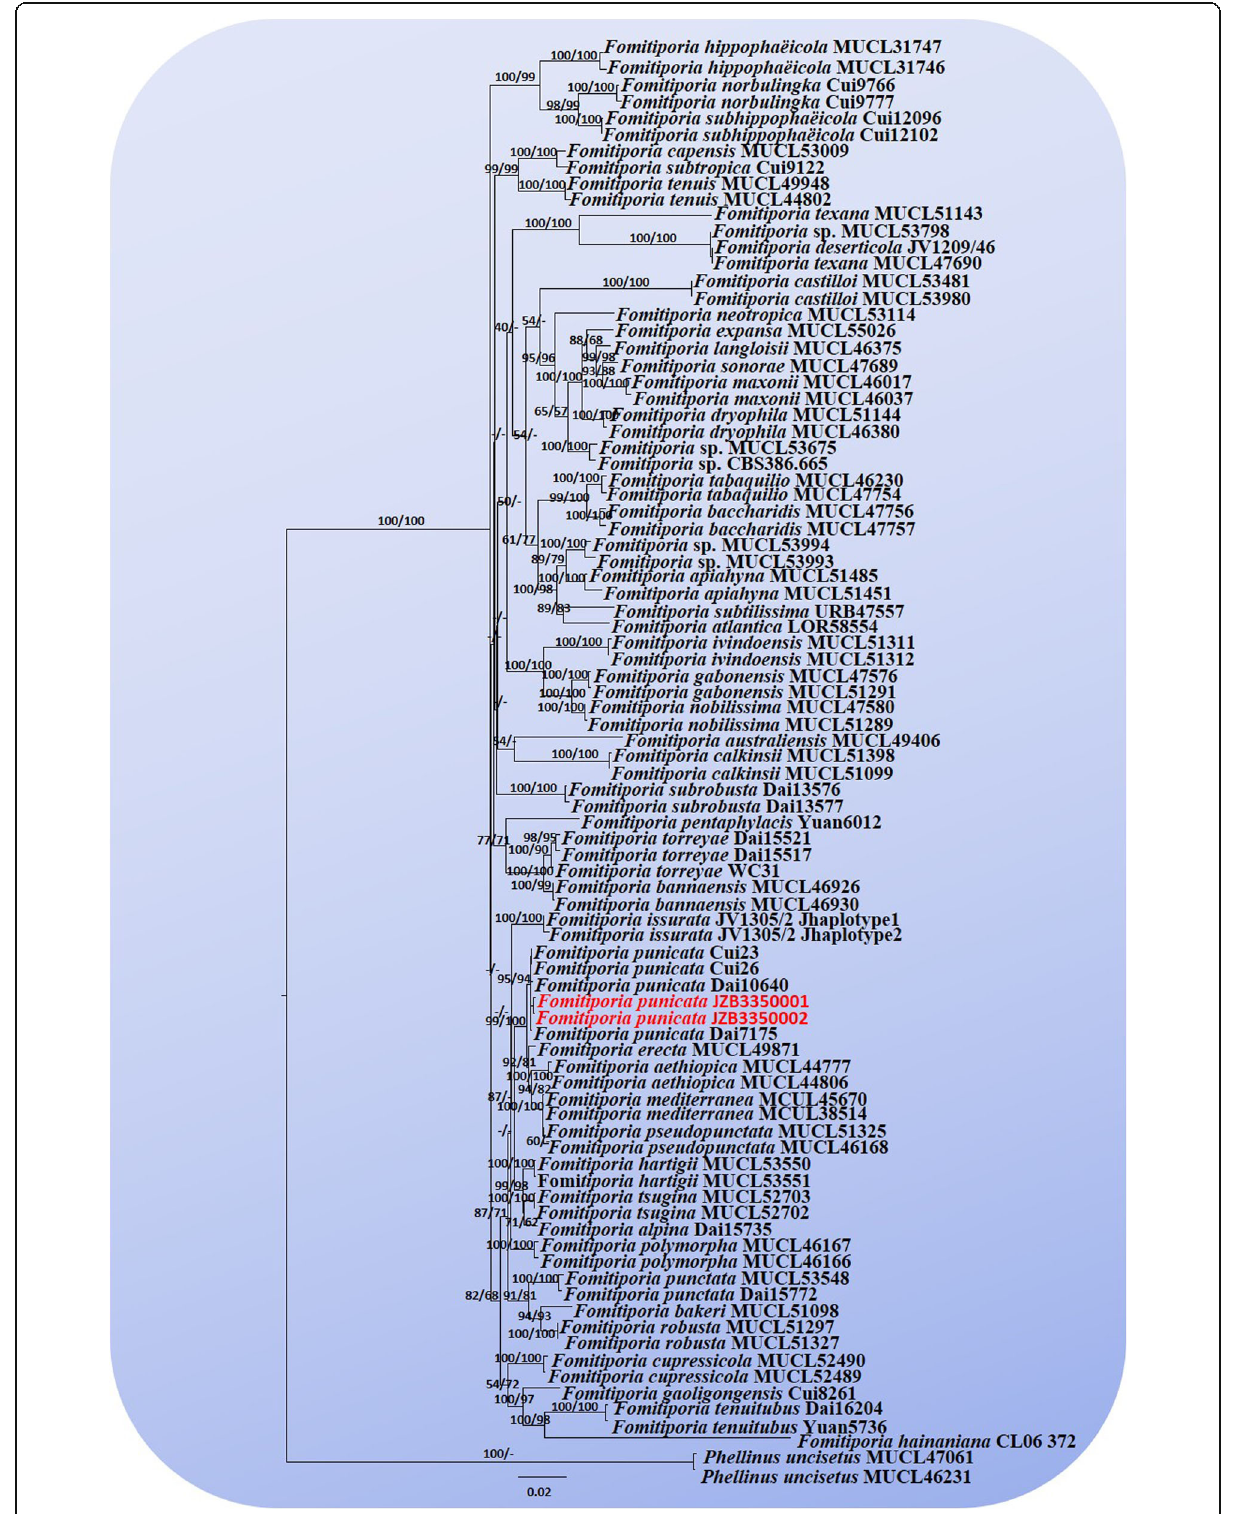
Fig. 2 RAxML tree obtained from phylogenetic analysis of combined genes of LSU, ITS and EF1- α . Maximum likelihood and parsimony bootstrap values are showed in nodes (the values lower than 50% are not given). The scale bar shows 0.02 changes. The tree is rooted in Phellinus uncisetus (MUCL 47061 and MUCL